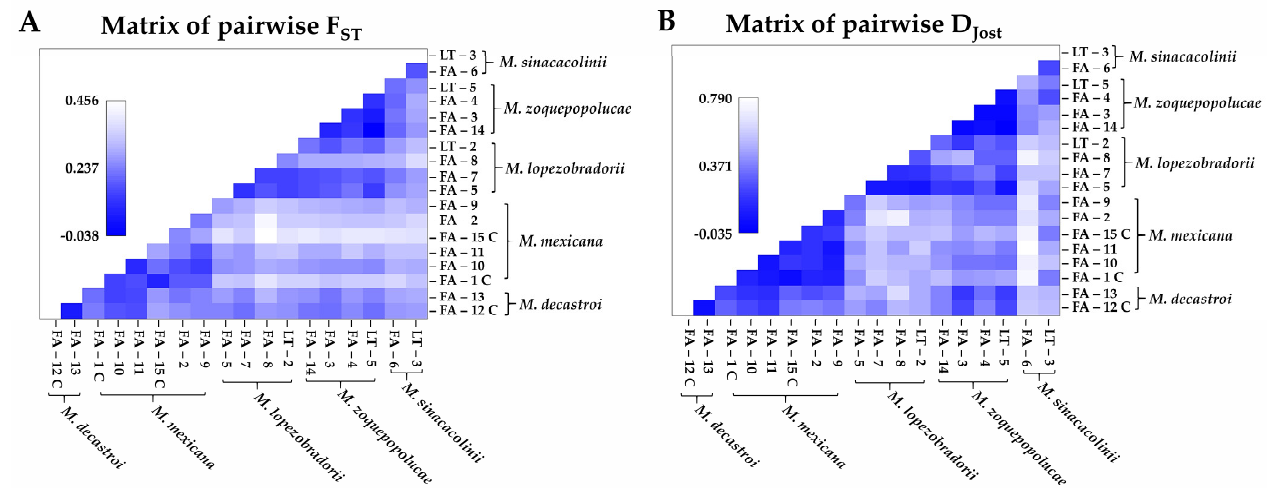
Figure 5. Pairwise F ST and D JOST values between the 18 localities of Magnolia species in Puebla and Veracruz, Mexico, visualized as a heatmap, C=cultivated. ( A ) Pairwise F ST values. ( B ) Pairwise D JOST values. Locality metadata can be found in Table 5.